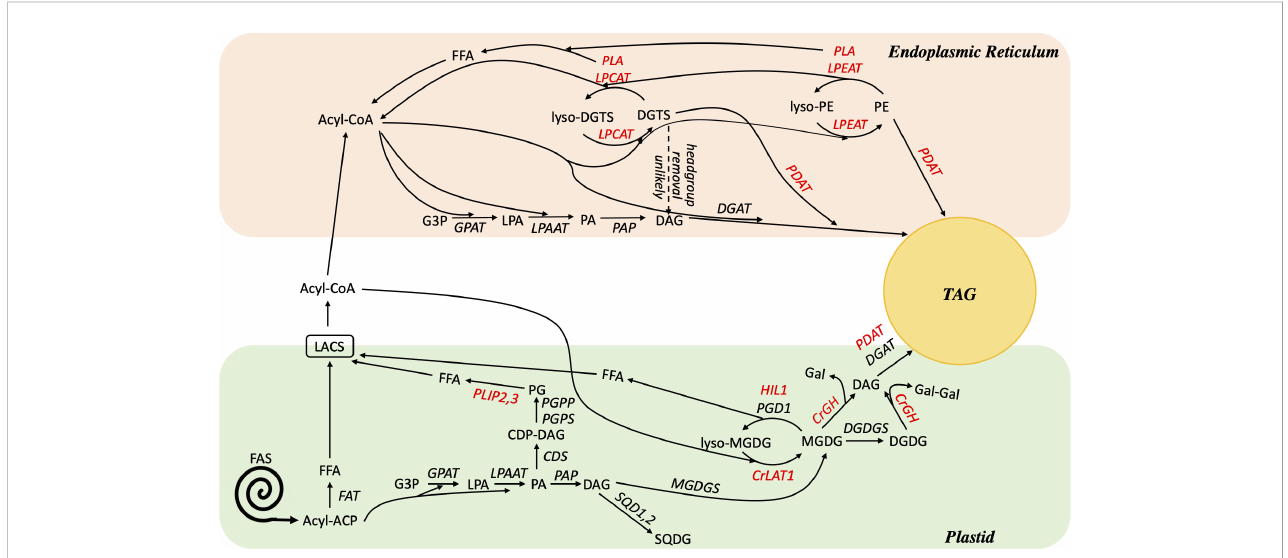
FIGURE 9 Working model of lipid metabolism in C. reinhardtii during TAG accumulation. Enzymes are shown in italics, for those shown in red further evidence is needed to test their role(s) and/or substrates in vivo . A dashed arrow indicates that for DGTS, headgroup removal or exchange is unlikely. Biosynthesis reactions of extraplastidial lipids DGTS, PE, and PI are omitted for simplicity. ACP, acyl carrier protein; CDP-DAG, cytidine diphosphate diacylglycerol; CDS, CDP-DAG synthase, CrGH, C. reinhardtii galactosyl hydrolase; CrLAT1, C. reinhardtii Lysolipid Acyltransferase 1; DAG, diacylglycerol; DGAT, diacylglycerol acyltransferase; DGDGS, digalactoslydiacylglycerol synthase; DGTS, diacylglyceryl-N,N,N-trimethylhomoserine; FAS, fatty acid synthase; FAT, fatty acyl-ACP thioesterase; FFA, free fatty acid; G3P, glycerol 3-phosphate; Gal, galactose; GPAT, glycerol-3-phosphate acyltransferase; HIL1, heat inducible lipase 1; LACS, long chain acyl-CoA synthetase; LPA, lysophosphatidic acid; LPAAT, lysophosphatidic acid acyltransferase; LPCAT, acyl-CoA: lysophosphatidylcholine acyltransferase; LPEAT, lysophosphatidylethanolamine acyltransferase; MGDG, monogalactosyldiacylglycerol; MGDGS, monogalactosyldiacylglycerol synthase; PA, phosphatidic acid; PAP, phosphatidic acid phosphatase; PDAT, phospholipid:diacylglycerol acyltransferase; PE, phosphatidylethanolamine; PG, phosphatidylglycerol; PGD1, Plastid Galactoglycerolipid Degradation 1; PGPP, phosphatidylglycerol phosphate phosphatase; PGPS, phosphatidylglycerolphosphate synthase; PLA, phospholipase; PLIP2, 3, plastid lipase 2, 3; SQD1, 2, sulfoquinovosyldiacylglycerol synthase; SQDG, sulfoquinovosyldiacylglycerol; TAG,